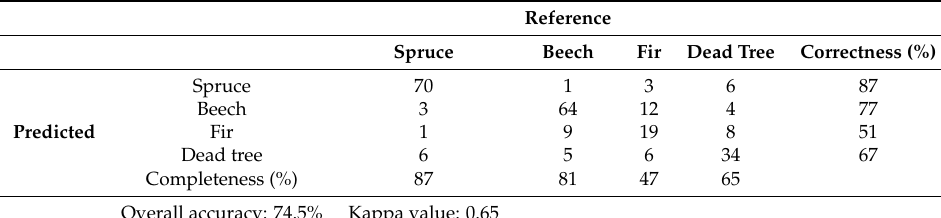
Table 7. Confusion matrix of scenario 6 using features extracted from single wavelength (1064 nm) ALS point cloud from test data set.